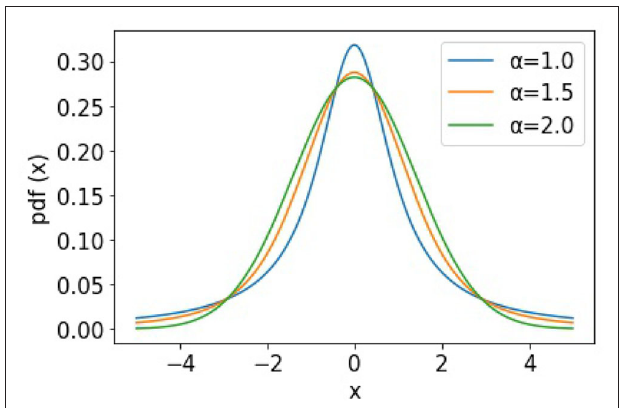
FIGURE 3 | Figure showing the probability density functions of the α Lévy process L α t for varying values of α .